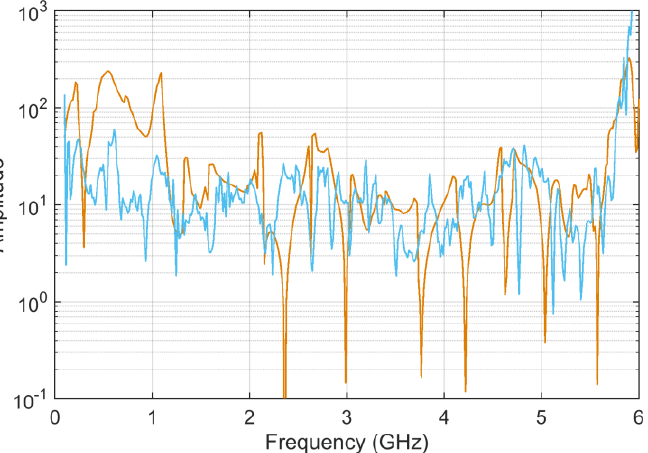
Figure 16. Normalized sensitivity coefficients for S 11 curves in logarithmic scale: S ADMi is shown in light brown and S FDMi in light blue.